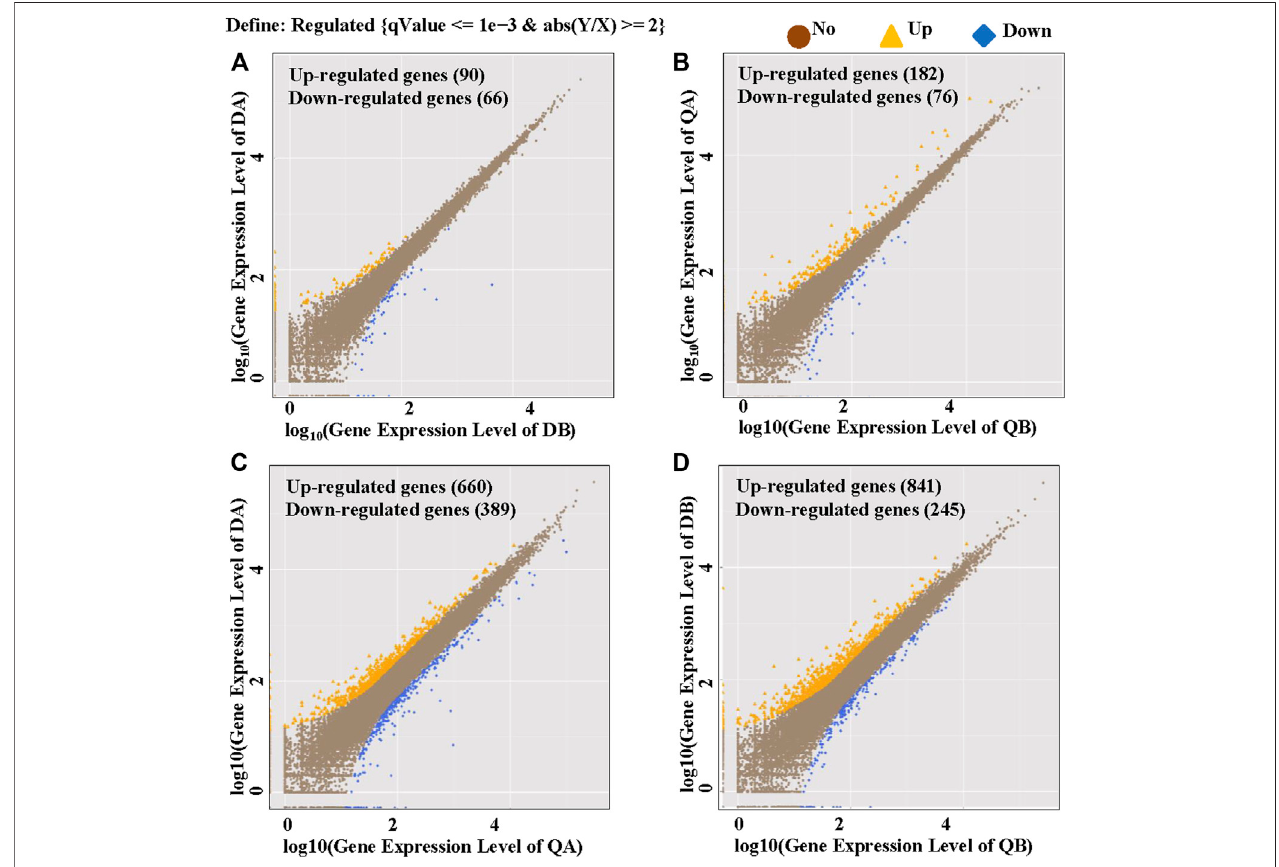
FIGURE 3 | Identi fi cation of DGEs between the two poplar lines grown in the two different environments. Upregulated genes are shown in yellow, downregulated genes are shown in blue, and genes that are not differentially expressed are shown in brown. (A,B) The log 10 (Gene Expression Level of ABJ01) (y-axis) plotted against thelog 10 (GeneExpressionLevelof9#)(x-axis)inDaqing (A) andQiqihar (B) . (C,D) Thelog 10 (GeneExpressionLevelofABJ01or9#fromDaqing)(Y-axis)plottedagainst the log 10 (Gene Expression Level of ABJ01 or 9# from Qiqihar) (x-axis); DA vs. QA (C) and DB vs. QB (D) .